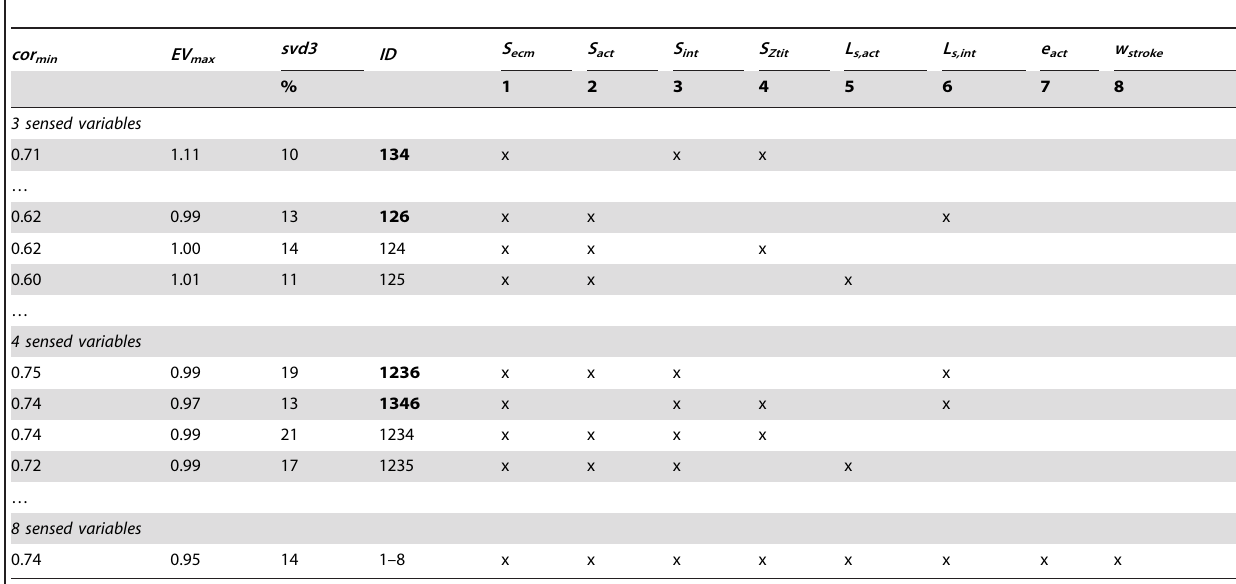
Table 3. Quality of reconstruction with combinations of sensed